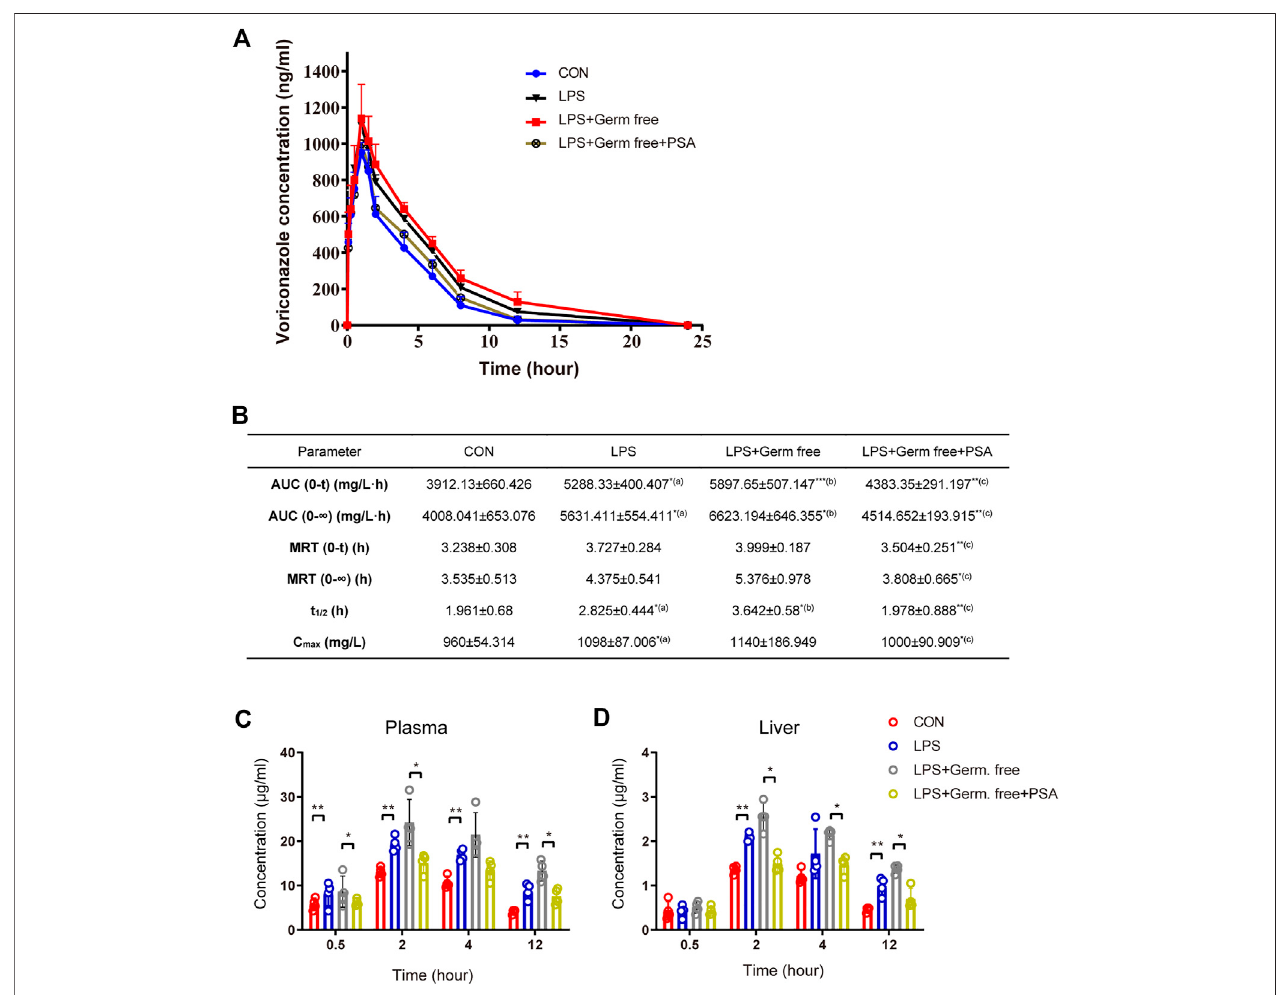
FIGURE4| VRCmetabolismbyLPSwithorwithoutPSAtreatedratsandmice. (A) VRCplasmakineticsinindividualrats( n (cid:1) 5,respectively). (B) Pharmacokinetic (PK) parameters in rats. (C) VRC blood concentrations in individual mice ( n (cid:1) 5, respectively). (D) VRC liver tissue concentrations in individual mice. The PK parameters were calculated according to the noncompartmental PK calculated by DAS 2.0 software. Tmax, maximum time corresponding to Cmax; AUC (0- ∞ ), area under the curve from 0 to ∞ ; MRT, Mean residence time; t1/2, half-life; Cmax, maximum concentration; Rats receiving a single dose of VRC, 10 mg/kg; Mice receiving a singledoseofVRC,10 mg/kg.(a)LPS vs. CON;(b)LPS+Germfree vs. LPS;(c)LPS+Germfree+PSA vs. LPS+Germfree.Unpaired t test,* p < 0.05,** p < 0.01,*** p < 0.001.